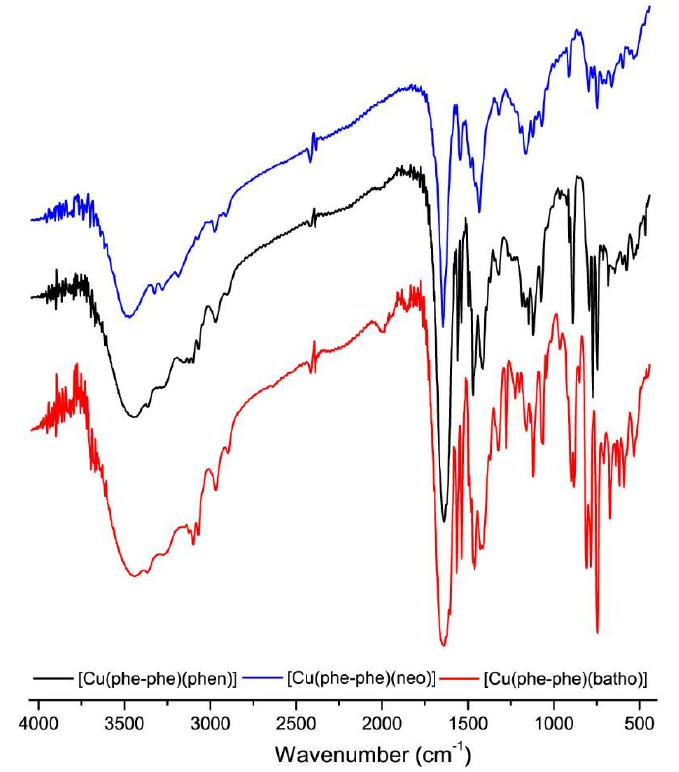
Figure 3. Superimposed IR spectra of: [Cu(L-Phe-phe)(diimine)] with diimine: phen (black), neo (blue), and batho (red).